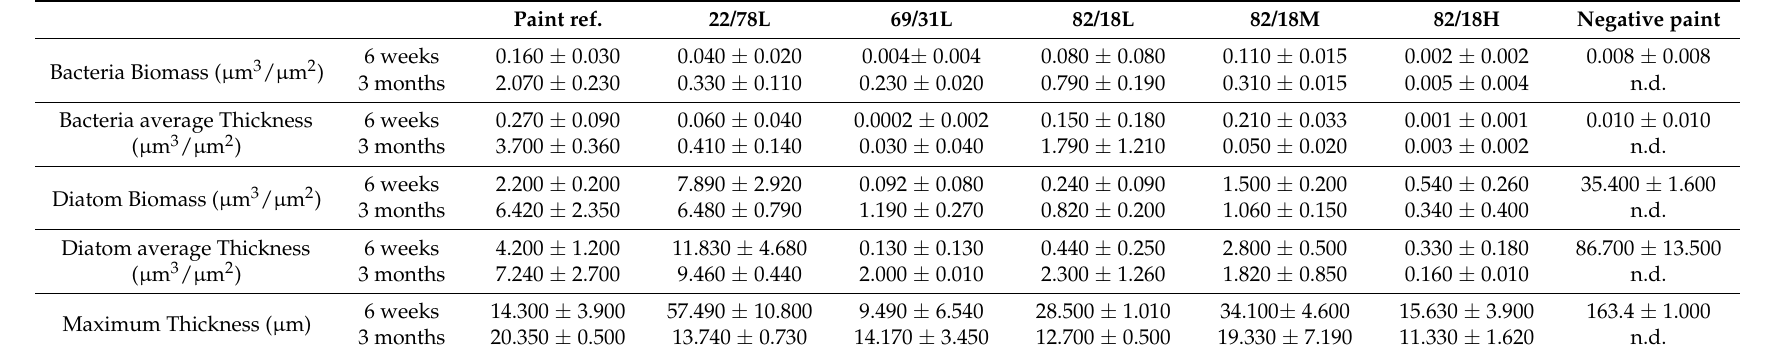
Table 5. Marine biofilm on paints after immersion in